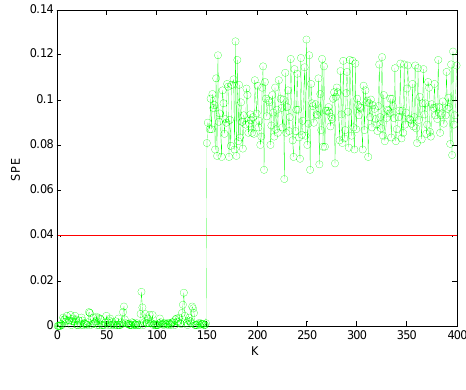
Figure 10. SPE value with sensors 3, 4 reconstructed.